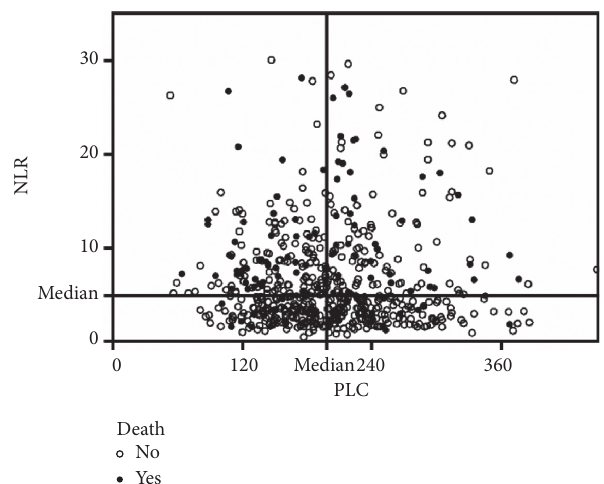
Figure 1: Correlation between PLC and NLR. When PLC cutoff value of 198.00 and NLR cutoff value of 4.88 were used, 34.04% mortality occurred in the high PLC and high NLR group (right upper quadrant). There was a weak but negative correlation between PLC and NLR: r � − 0.102, p � 0 . 010. Abbreviations: PLC, platelet count; NLR, neutrophil-to-lymphocyte ratio. Table 2: Angiographic and procedural characteristics in the study population.